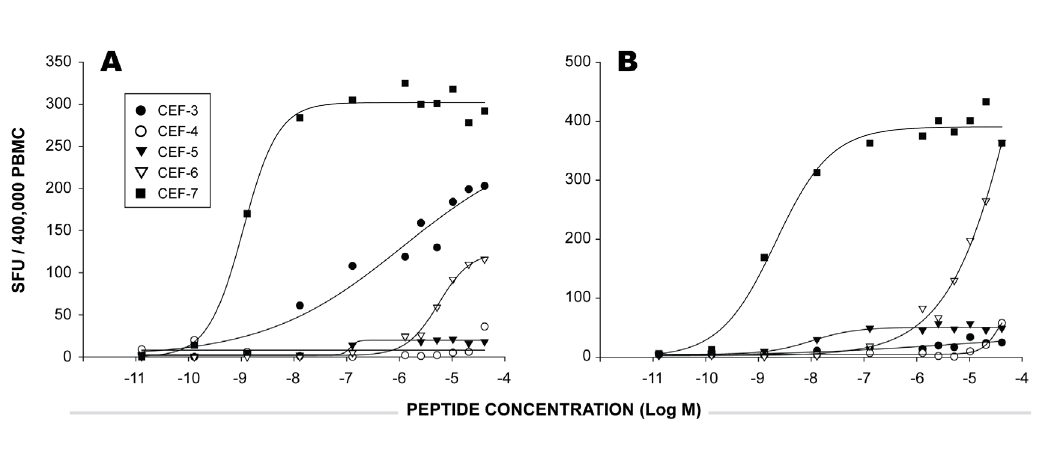
Figure 2. The functional avidity of CEF peptide-reactive CD8 T cells as exemplified in two donors. In each panel depicts one HLA-A2-0201 positive donor. The PBMC were tested in an IFN- γ ELISPOT assay with decreasing concentrations of five HLA -A2 restricted CEF peptides (CEF 3, 4, 5, 6, 7, as specified by the symbols). Each data point represents SFU from a single well. For each donor the SFU were plotted on the Y axis against the concentration of peptides used for stimulation in the X